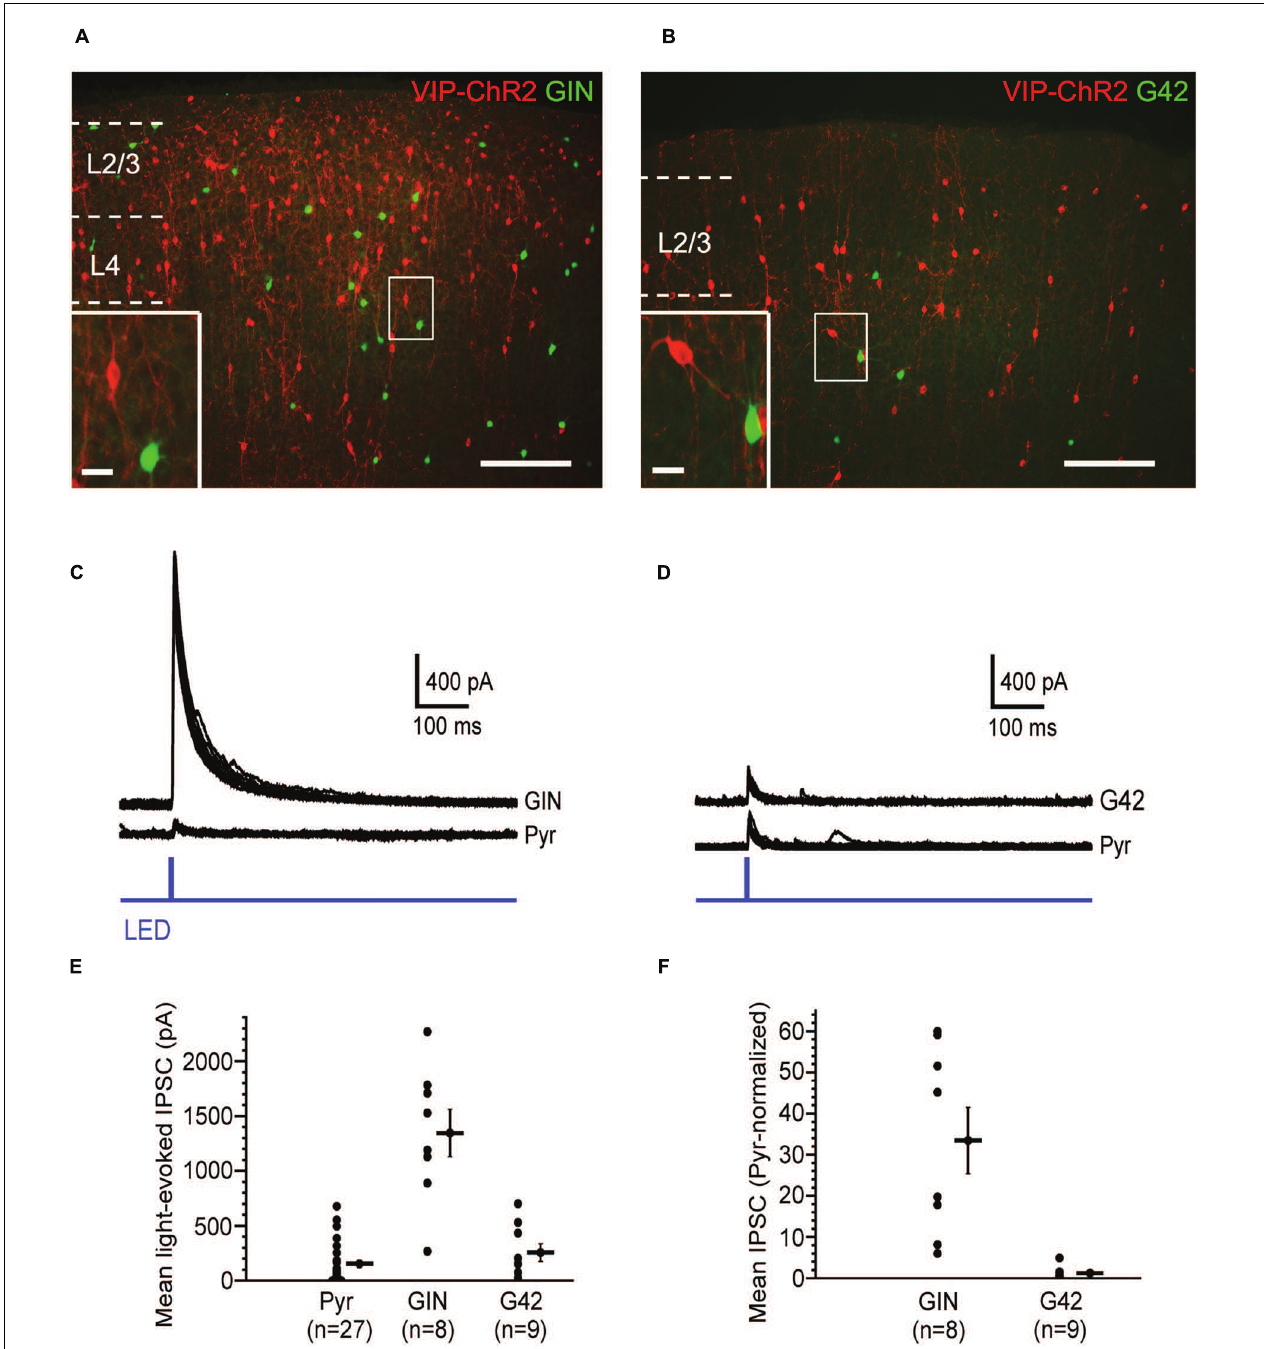
FIGURE 3 | Vasoactive intestinal peptide (VIP) cells strongly inhibit SOM cells. (A) Fluorescent image of barrel cortex of GIN mouse (endogenous GFP in subset of SOM cells) crossed with VIP-Cre mouse, virally transfected with Cre-dependent, RFP-tagged ChR2; scale bar = 200 µ m. Inset: expanded view of neighboring VIP cell (red) and GIN cell (green); scale bar = 20 µ m. (B) Fluorescent image of barrel cortex of G42 mouse (endogenous GFP in subset of PV cells) crossed with VIP-Cre mouse, virally transfected with Cre-dependent, RFP-tagged ChR2; scale bar = 200 µ m; dotted line denotes pia. Inset: expanded view of neighboring VIP cell (red) and G42 cell (green); scale bar = 20 µ m. (C) Light-evoked IPSCs in a GIN cell and neighboring pyramidal cell in layer 2/3, in which VIP cells express ChR2. 10 traces overlaid for both GIN and pyramidal cell. (D) Light-evoked IPSCs in a G42 cell and neighboring pyramidal cell in layer 2/3, in which VIP cells express ChR2. 10 traces overlaid for both G42 and pyramidal cell. (E) Population data of mean light-evoked IPSCs in pyramidal, GIN, and G42 cells when VIP cells are optogenetically activated. IPSC GIN > IPSC Pyr ( P = 1.1 × 10 − 5 , Kruskal–Wallis test, Bonferroni correction), IPSC GIN > IPSC G 42 ( P = 4.3 × 10 − 4 , Kruskal–Wallis test, Bonferroni correction). (F) Population data of mean light-evoked IPSCs in GIN, and G42 cells, normalized to mean light-evoked IPSCs in pyramidal cells in same slice, when VIP cells are optogenetically activated, normIPSC GIN > normIPSC G 42 ( P = 4.4 × 10 − 4 , Mann–Whitney test).